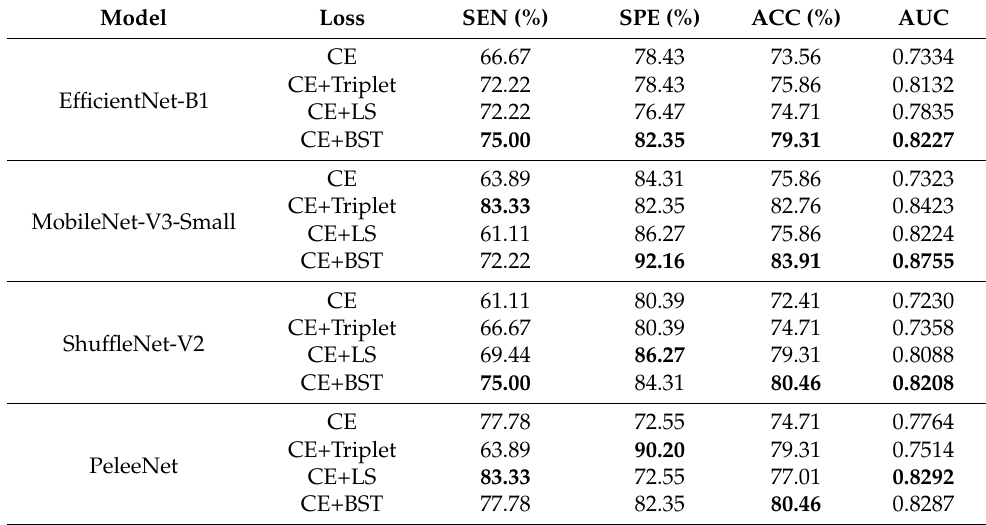
Table 8. Metrics for the compared networks on the rash image